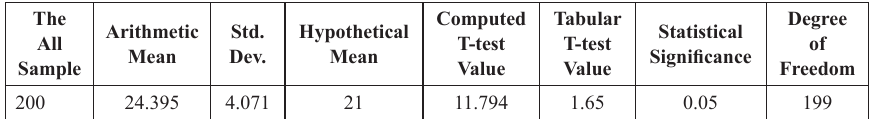
Table 5. The mean and the T-value (questions (correction of 6 marks))